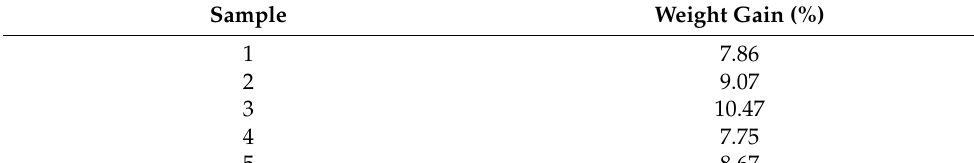
Table 2. Weight gain of wood samples mineralized for the fire-resistance tests.